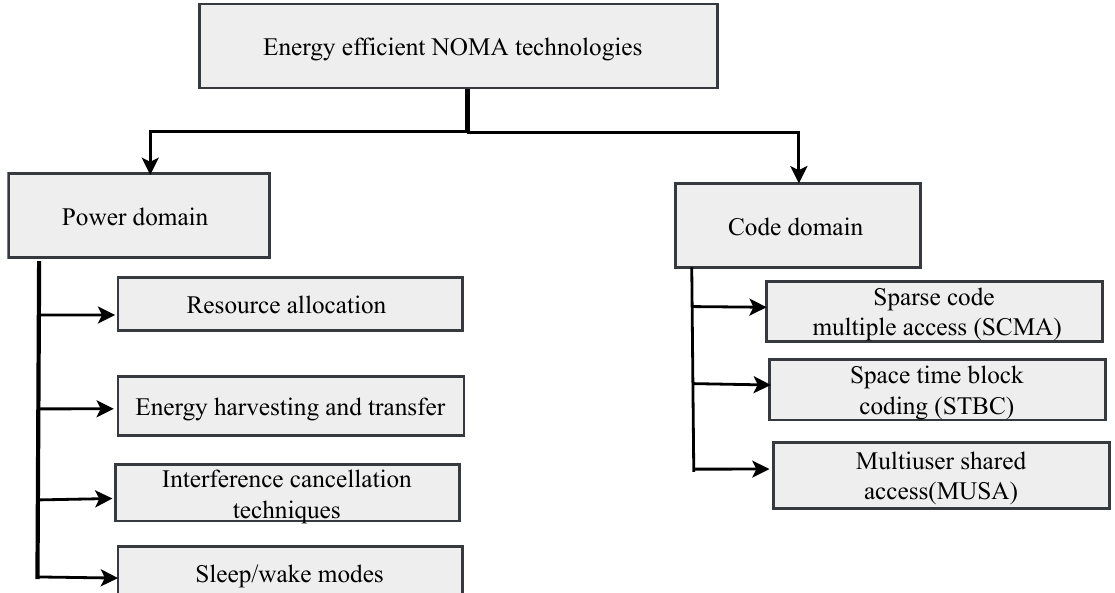
Figure 2. Classification of green technologies for NOMA based on existing research work discussed in this